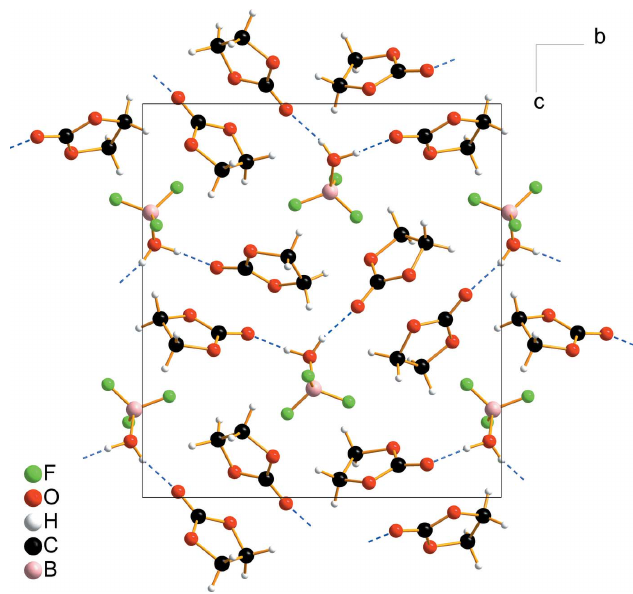
Figure 2 Crystal packing of BF 3 H 2 O (cid:2) 2OC(OCH 2 ) 2 viewed along [100]. Hydrogen bonds are indicated by blue dashed lines.